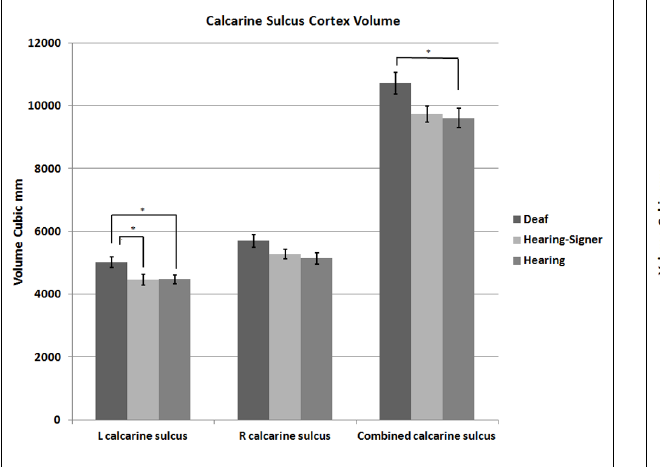
FIGURE 2 | Calcarine sulcus cortex volume. Deaf individuals have significantly larger calcarine volume than hearing individuals (error bars: ± 1 standard error; * p < 0.05).